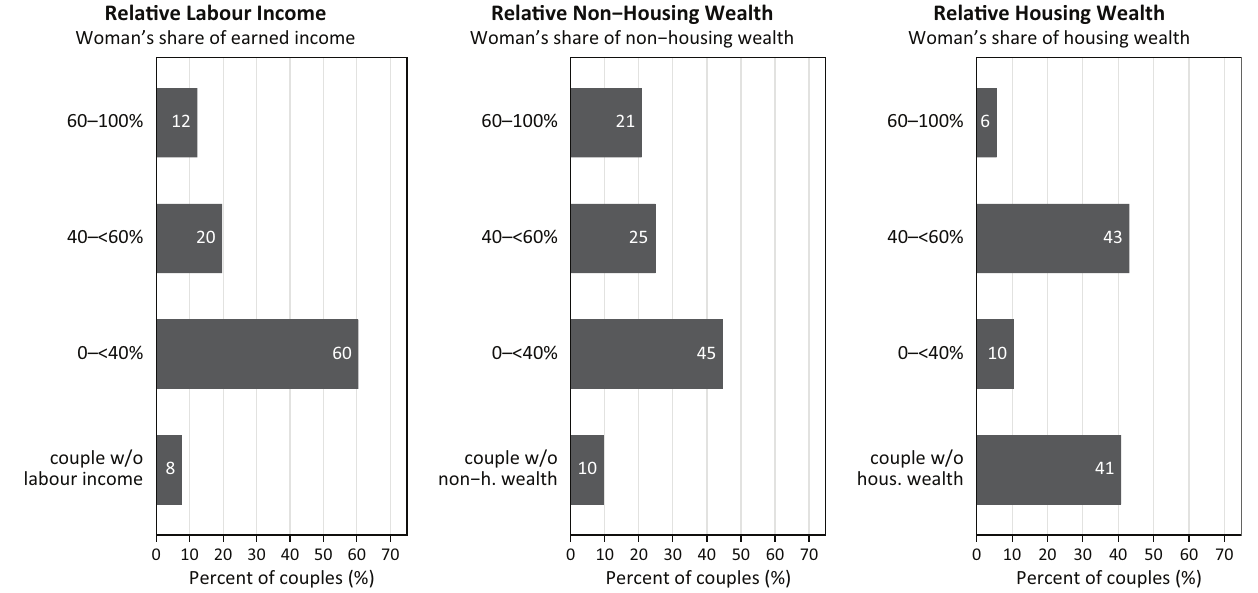
Figure 1. Distribution of labour income, non‐housing wealth, and housing wealth within couples. Notes: Based on SOEP v36; unweighted; first set of imputed values used; 𝑁 = 8874